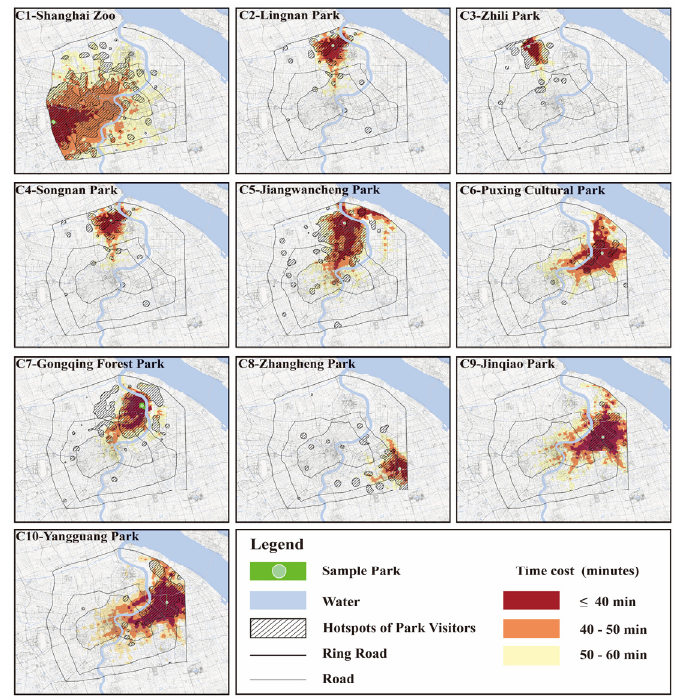
Figure A2. Comparative analysis between park service area and accessibility (Category C).